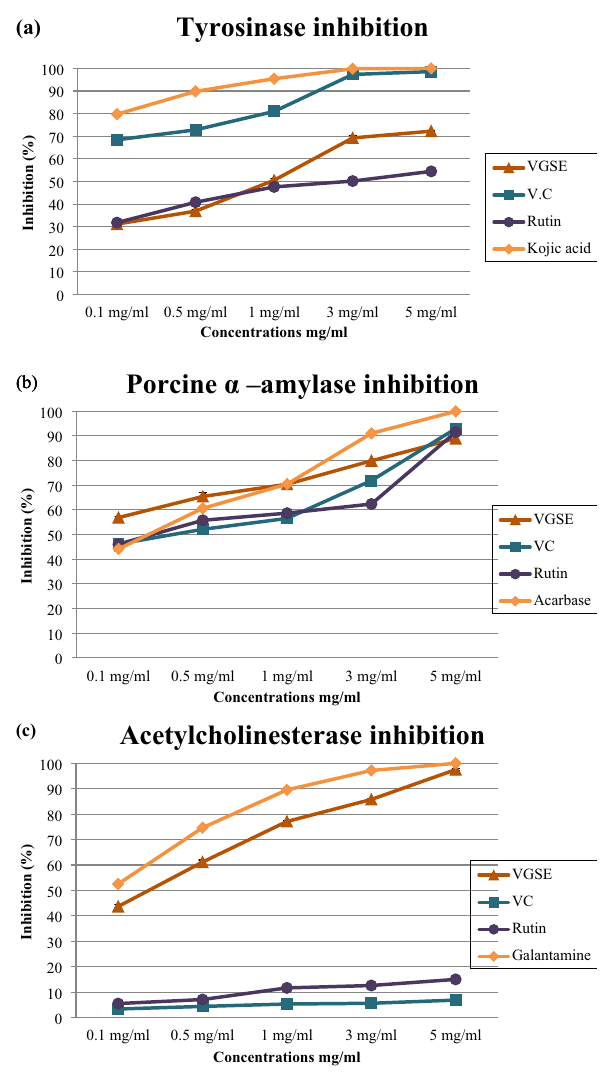
Figure 2. ( a ) Tyrosinase inhibition activity, ( b ) Porcine α-amylase inhibition activity, and ( c ) Acetylcholinesterase inhibition activity for VGSE, antioxidant compounds, or enzyme activity inhibition standards at different concentrations; Values are means ± SD of three